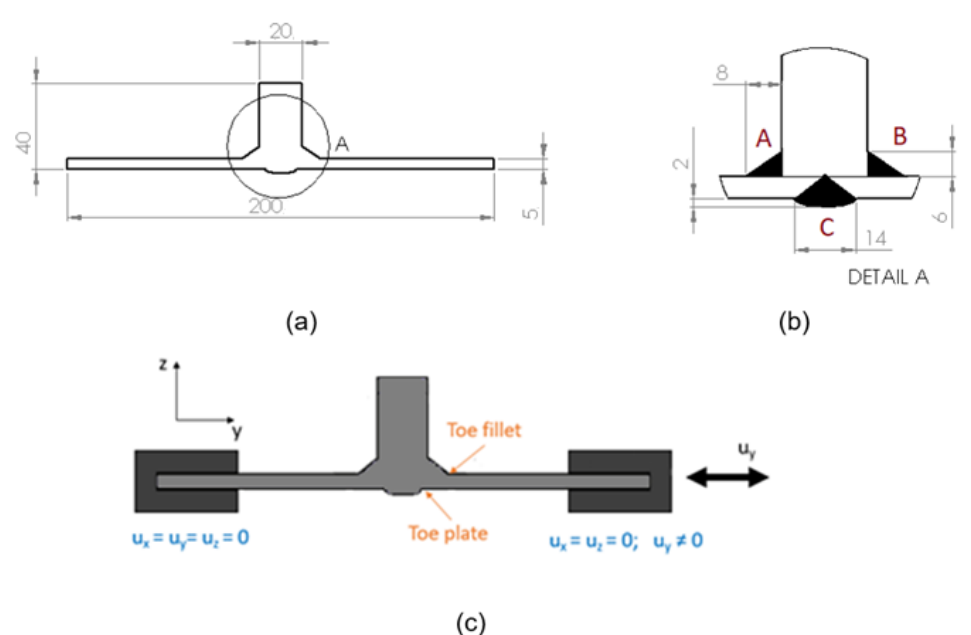
Figure 1. Geometry ( a ),weld details ( b ), boundary and loading conditions ( c ) of welded speci- mens. Table 1. Mechanical properties of the investigated Al alloy. Ultimate